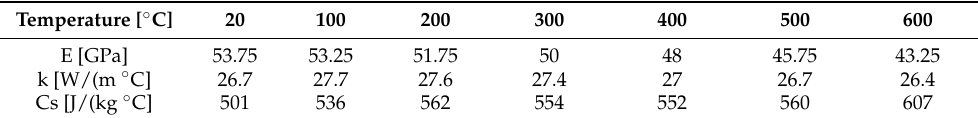
Table 2. Variation of the Young modulus, the thermal conductivity and specific heat capacity with